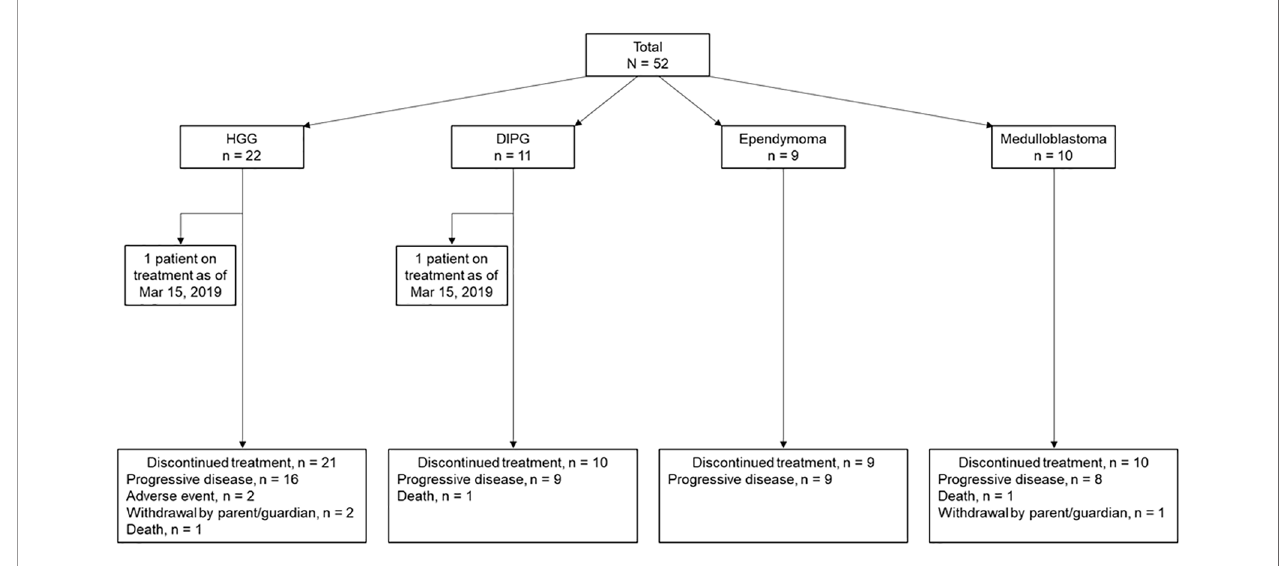
FIGURE 1 | Patient Disposition by Tumor Type (safety population).